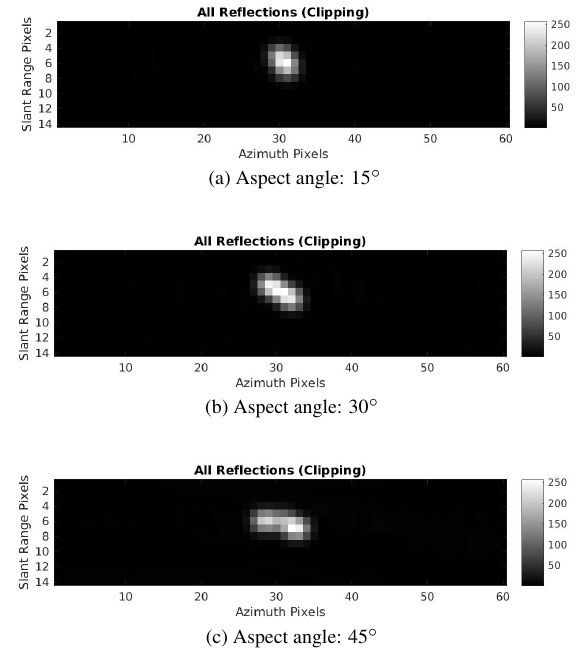
Figure 12. Simulated SAR images for street signs (staring spotlight mode) with an signal incidence angle of 40 ◦